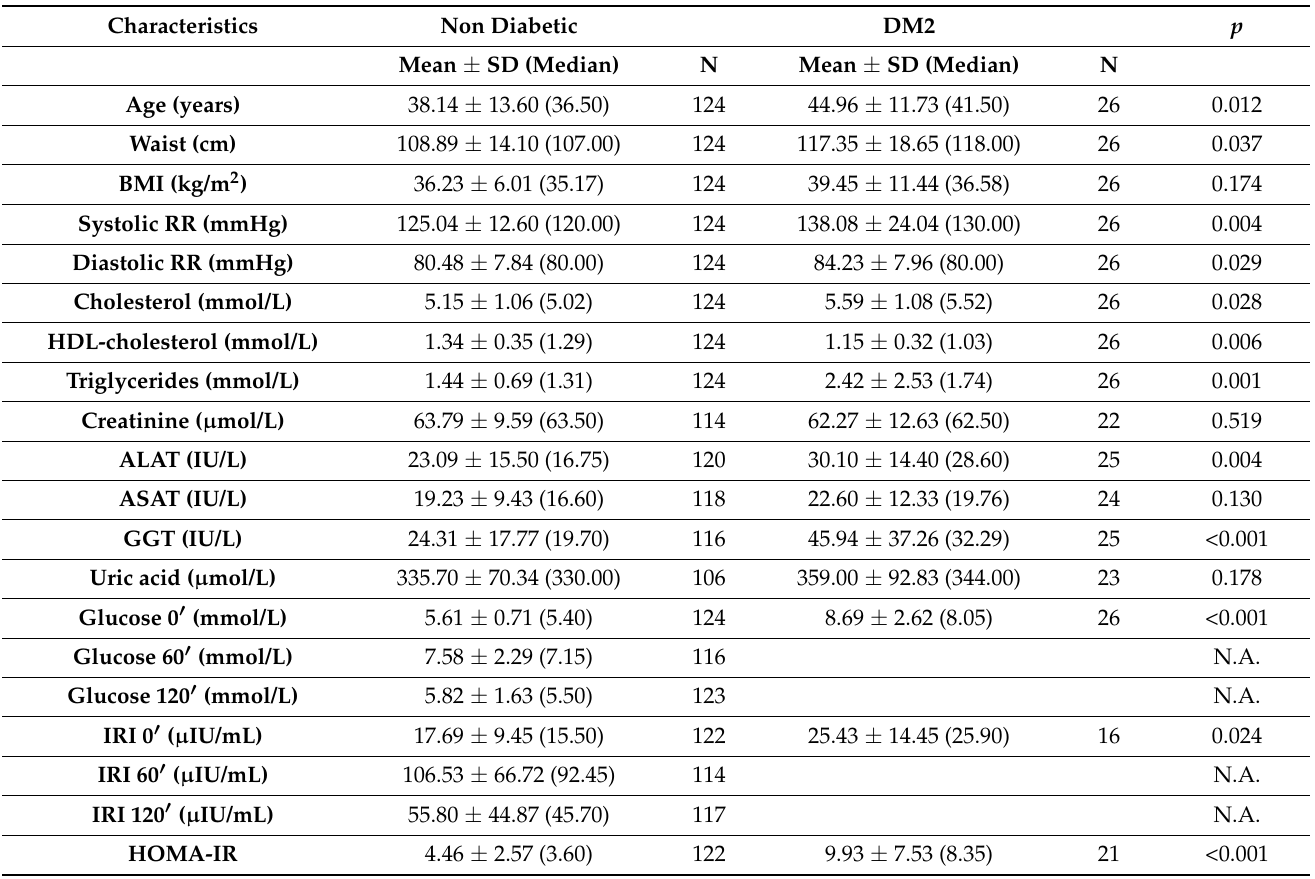
Table 1. Characteristics of overweight and obese female patients without diabetes mellitus type 2 (Non diabetic) compared to overweight and obese women with diabetes mellitus type 2